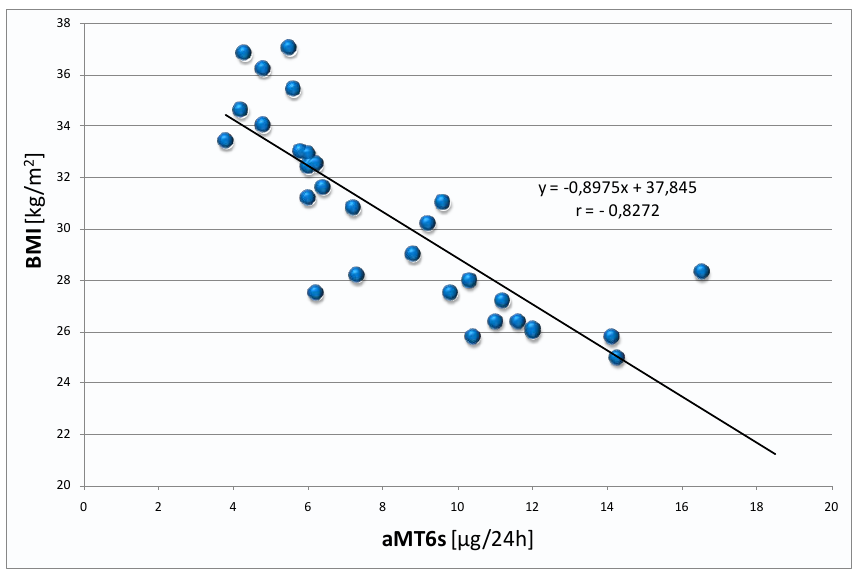
y = -0,8975x + 37,845 r= -